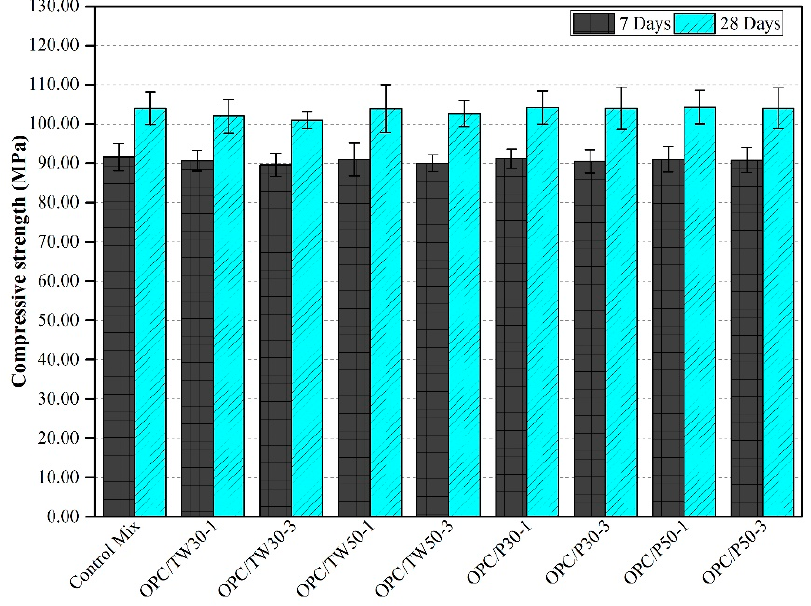
Figure 3. Compressive strength of mortars made with tea waste and perlite particles without SF.